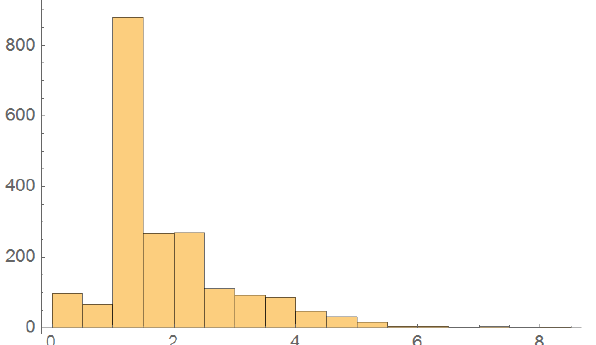
Figure 7 . Distribution of log (cid:11) i . Here (cid:11) i is randomized in [ (cid:0) 1 ;